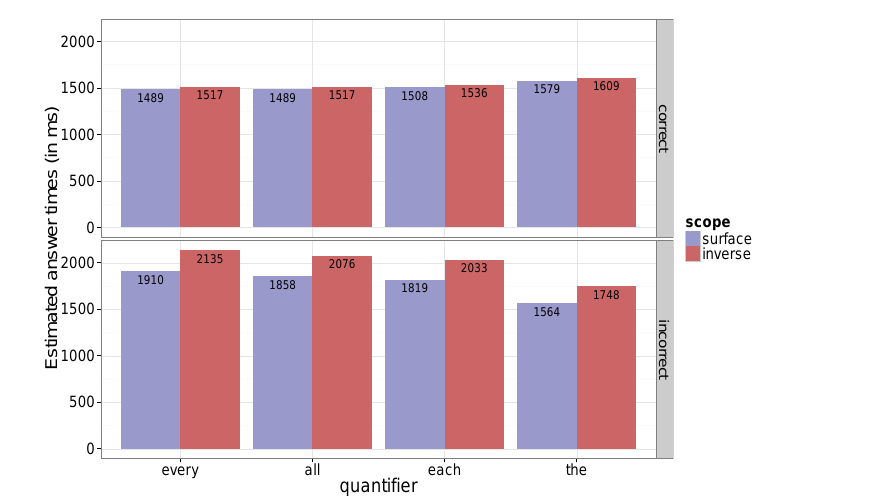
Figure 5 Experiment 1 : Estimates for answer times based on the model in Table 3